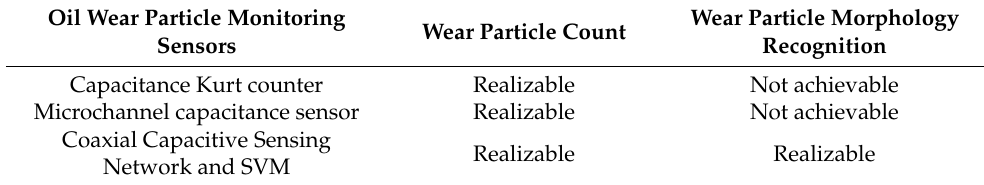
Table 9. The proposed method is compared with the most advanced monitoring sensor for lubricating oil wear